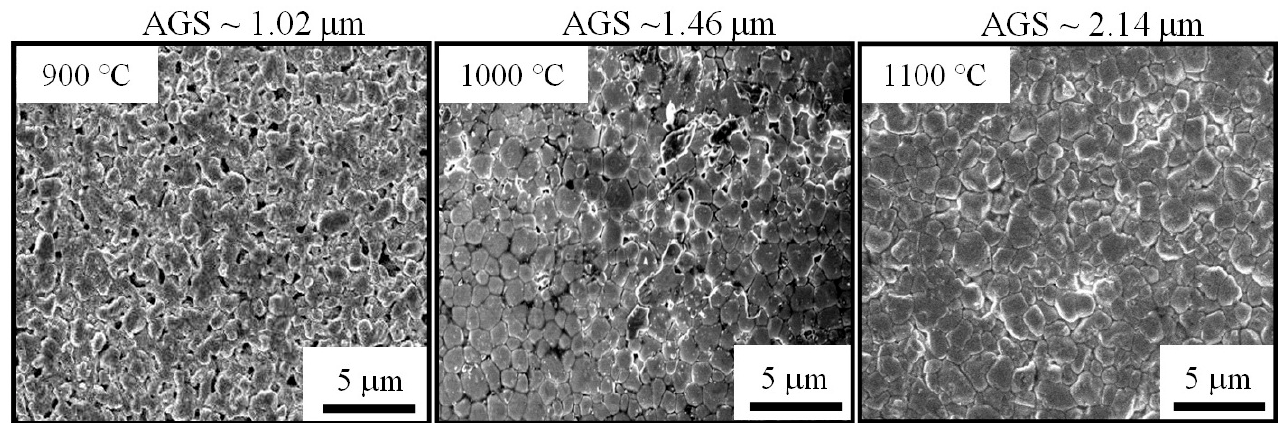
Figure 7. Surface FE-SEM micrographs of sintered ceramics.